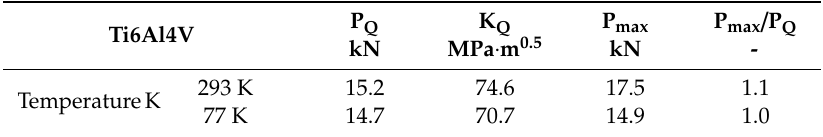
Figure 8. Diagrams of load-COD determined during tests of maximal experimental value of stress intensity factor K Q determined for titanium alloy Ti6Al4V under ambient and cryogenic conditions. Table 4. Results of fracture toughness tests in a linear-elastic range of Ti6Al4V titanium under cryogenic and ambient